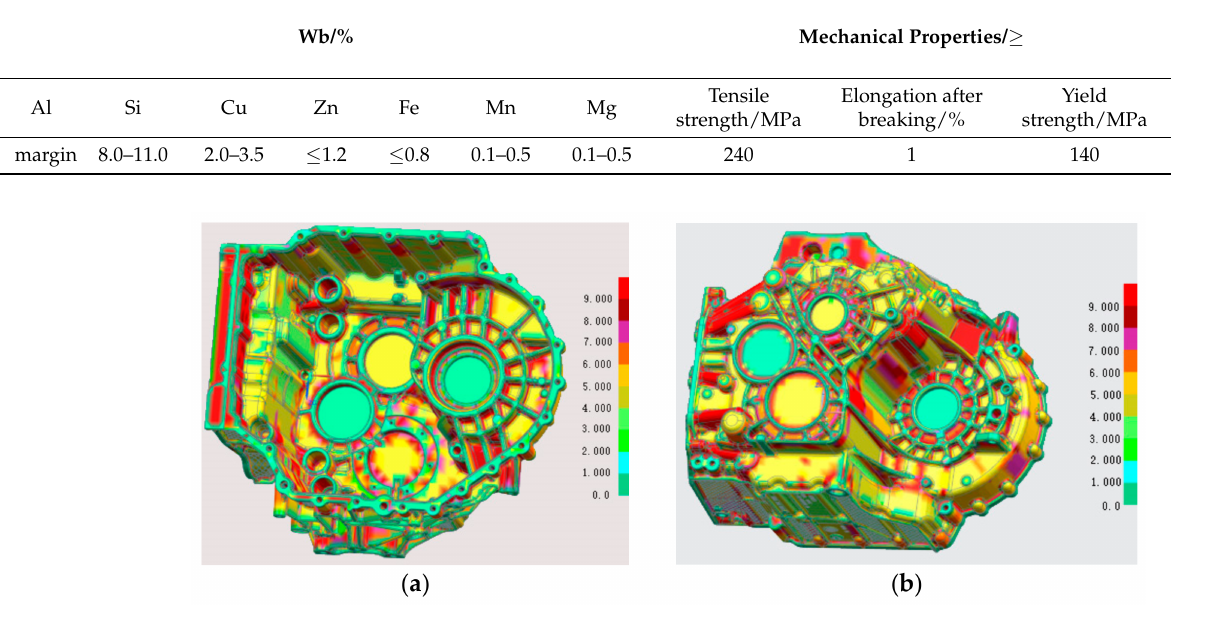
Figure 2. Wall thickness analysis diagram of gearbox. ( a ) Analysis diagram of bottom wall thickness of gearbox, ( b ) Analysis diagram of top wall thickness of